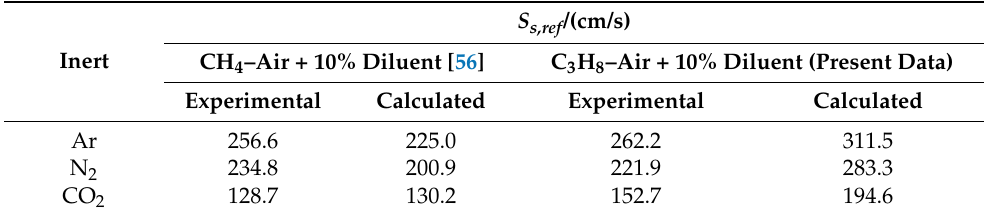
Table 5. Reference PVs for stoichiometric CH 4 –air + 10% diluent and for C 3 H 8 –air + 10% diluent mixtures. S s,ref /(cm/s) Inert Experimental Calculated Experimental Calculated